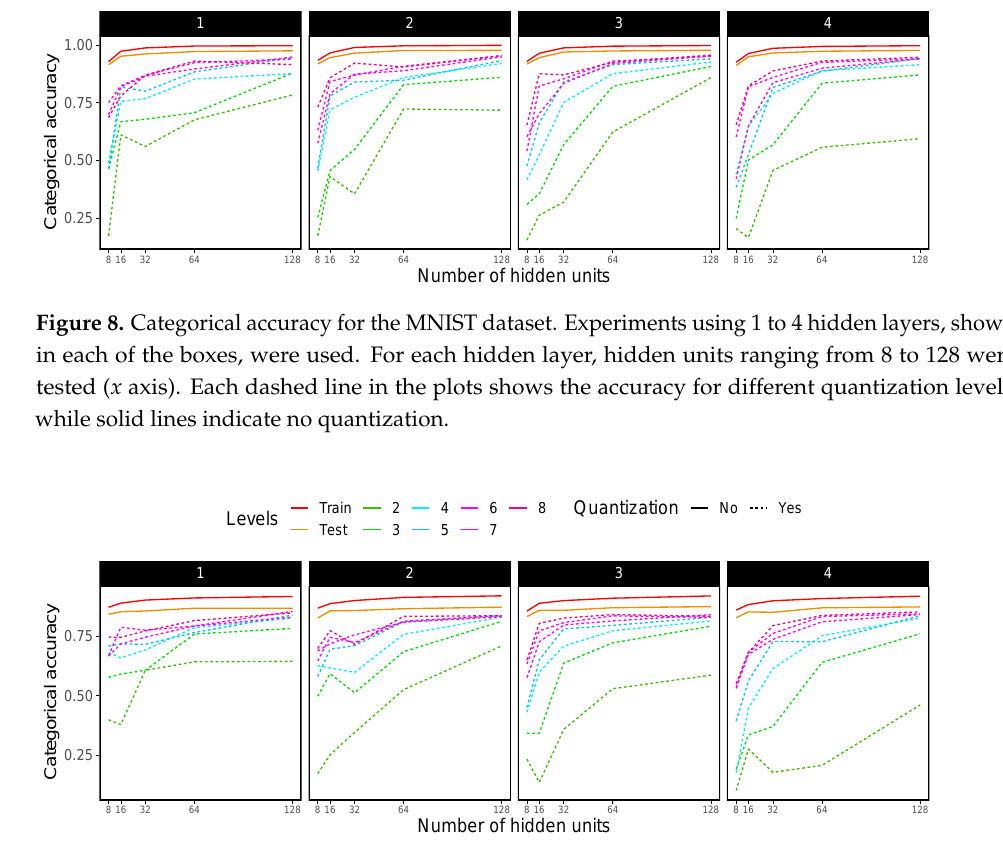
Figure 9. Categorical accuracy for the Fashion MNIST dataset. Experiments using 1 to 4 hidden layers, shown in each of the boxes, were used. For each hidden layer, hidden units ranging from 8 to 128 were tested ( x axis). Each dashed line in the plots shows the accuracy for different quantization levels, while solid lines indicate no